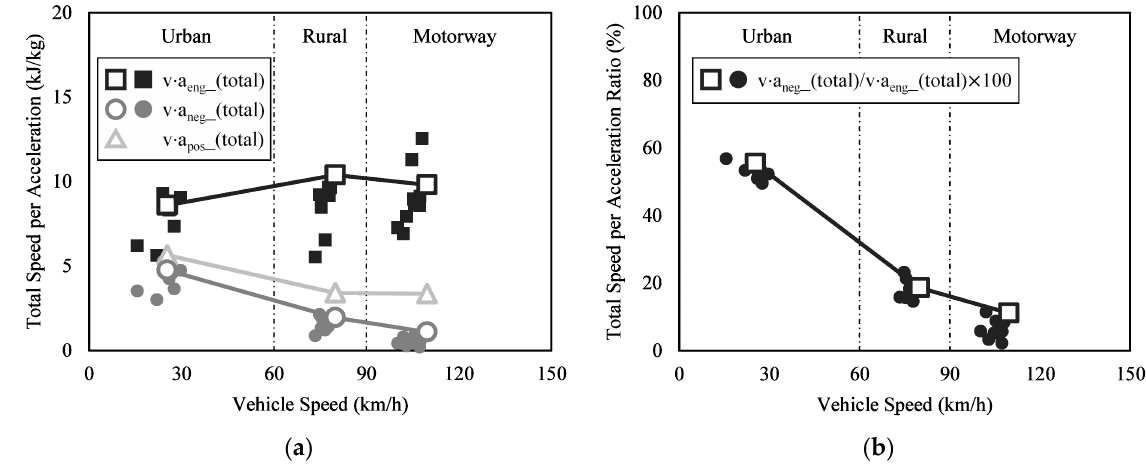
Figure 11. Comparisons of v·a_(total) and v·a_(total) ratio for the 10 test cases. ( a ) The v·a_(total) comparisons. ( b ) The v·a_(total) ratio comparisons.